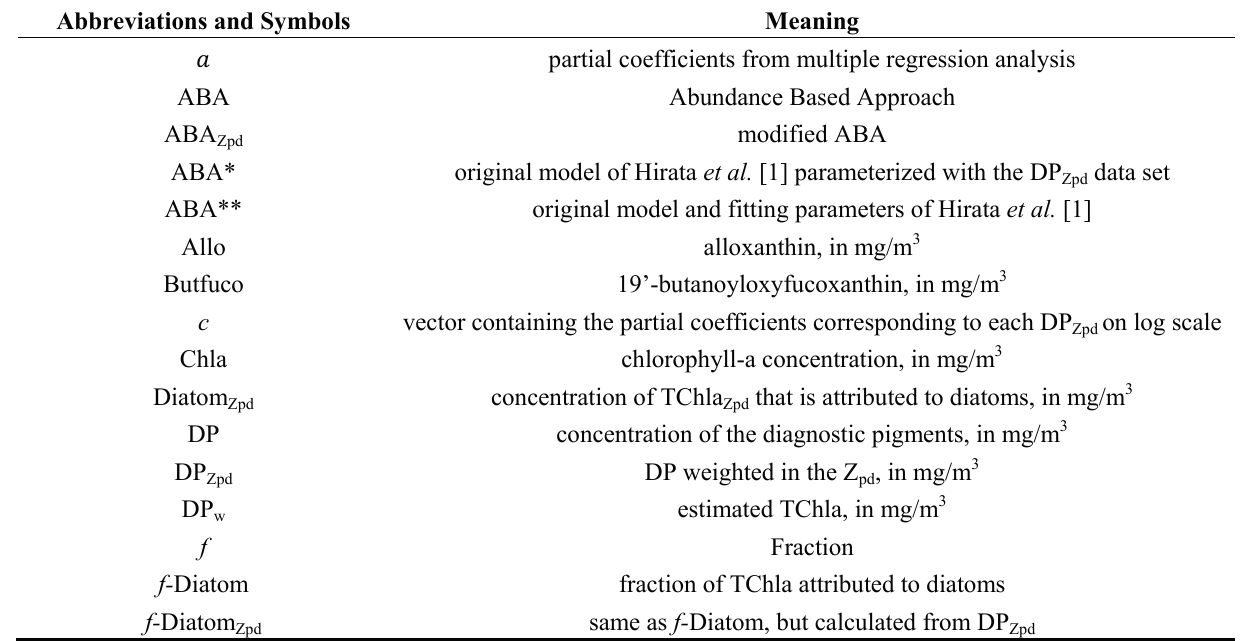
Table 1. Abbreviations and symbols used in this study and their meaning. Abbreviations and